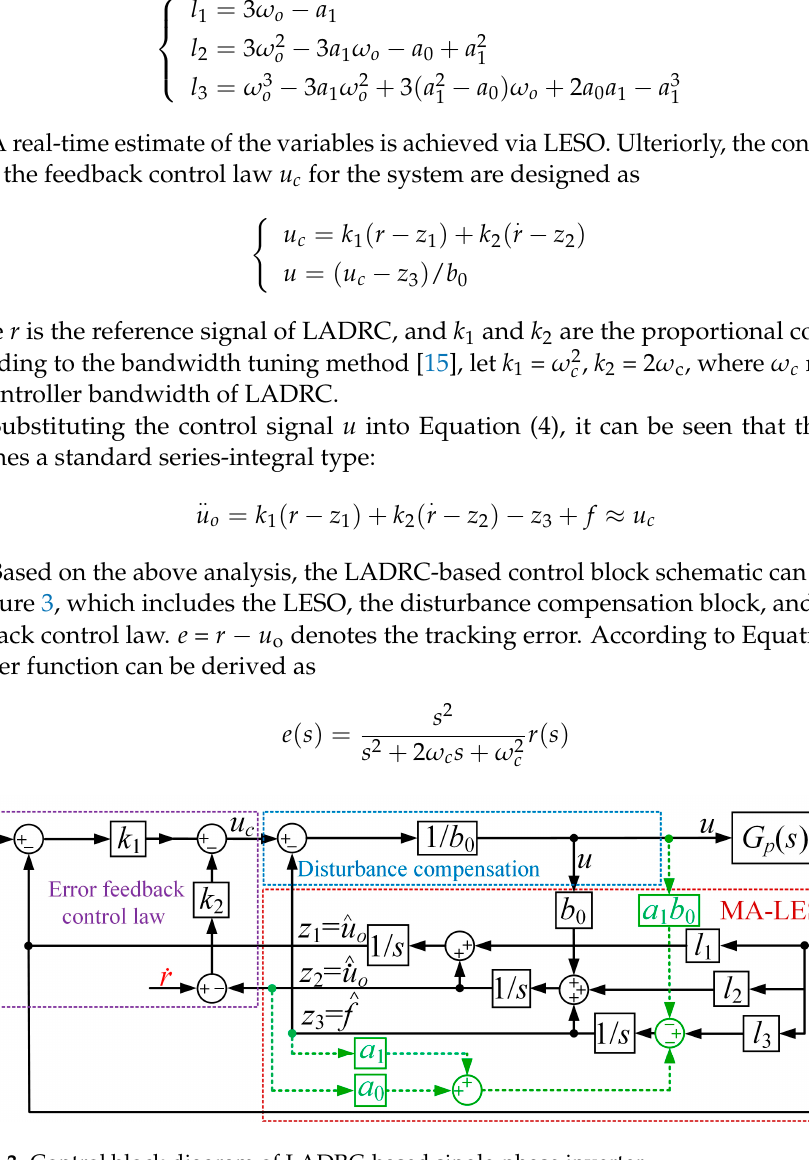
Figure 3. Control block diagram of LADRC-based single-phase inverter. The bode magnitude plots of the tracking error transfer function with and without differential reference is compared, as shown in Figure 4. Notice that the introduction of the differential reference helps to improve the voltage tracking performance. However, because the unknown periodic disturbances such as the changing loads and the observation errors of LESO still exist, the system cannot be accurately compensated. Thus, a non-negligible steady-state error and THDu still exist when a fixed differential reference is